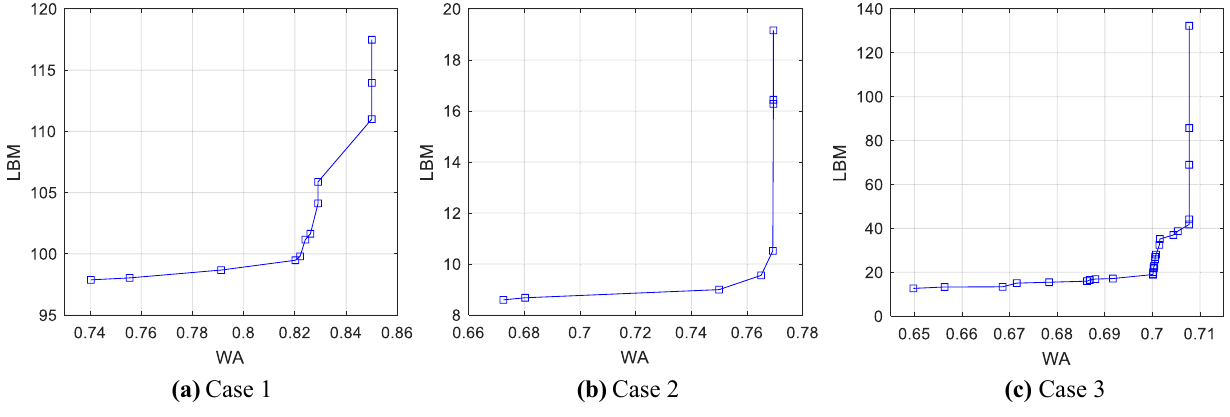
Fig. 10 Pareto front obtained using